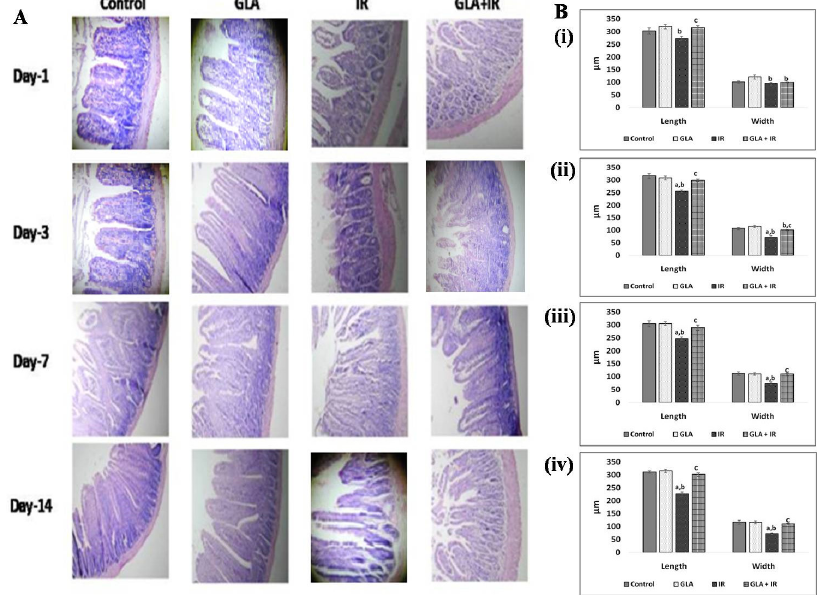
Figure 17. Histology of duodenum of surviving mice ( A ). Control, non-irradiated mice; GLA, mice treated with 100 μ g/kg GLA; IR, irradiated mice (7.5 Gy); GLA + IR, GLA-pre-treated and irradiated mice. On day 1, day 3, day 7, and day 14, cells were stained with hematoxylin and eosin (10× mag- nification). Villi length and width (in μ m) were measured ( B ). Values (n = 3) expressed as mean ± SEM. a , b , c Significant ( p < 0.05) when compared with control, GLA, and irradiation, respectively. GLA, gamma-linolenic acid; IR, irradiation (7.5 Gy).